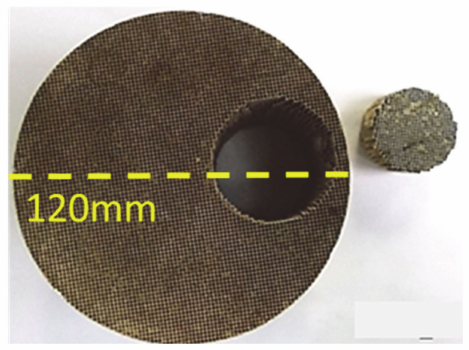
Figure 4. Carrot extraction from 15PROM2